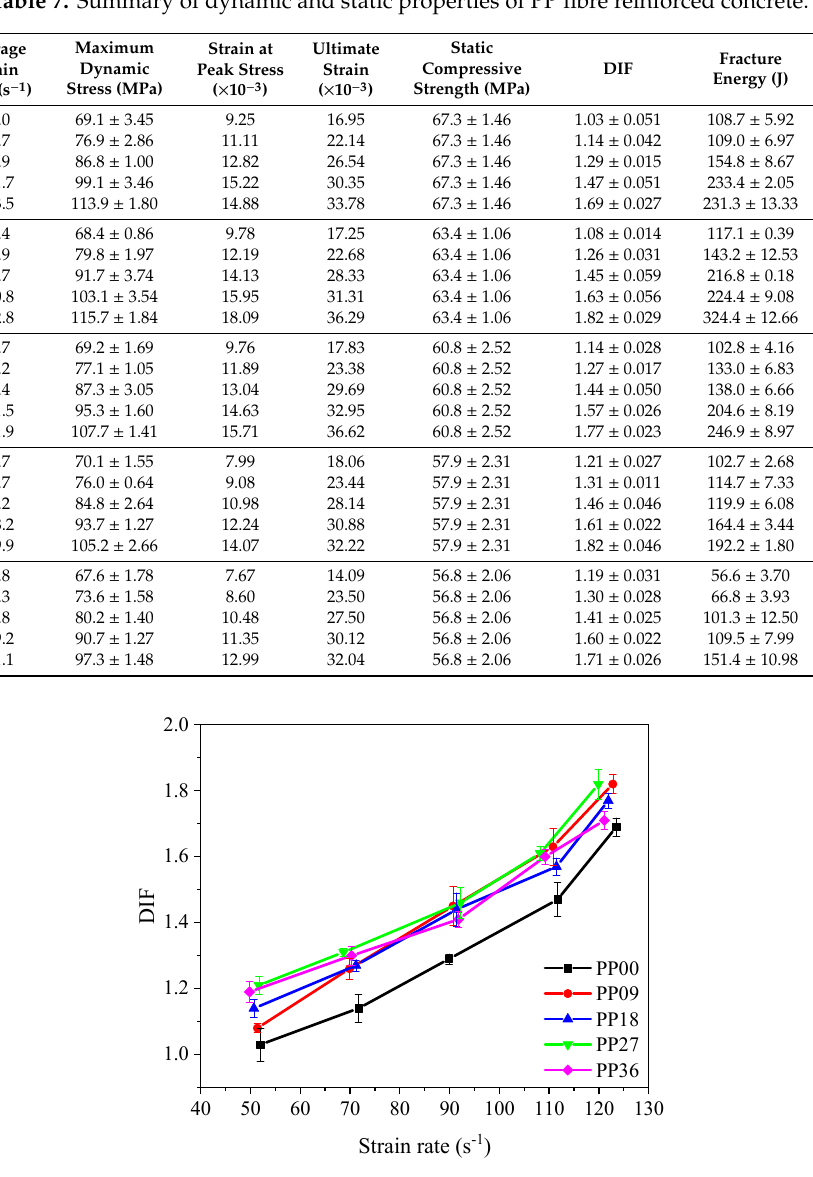
Figure 9. Energy absorption capacity of concrete at different strain rates:( a ) Fracture energy;( b ) Tolal energy. The deformation capacity of concrete materials can be represented by the strain at peak stress and ultimate strain listed in Table 7.The strain at peak stress and ultimate strain were improved with increasing strain rate. The ultimate strain of each mixture was higher than its strain at peak stress ranging from 83.2% to 173.3%.The ultimate strain of PP09 and PP18 in this study was higher than that of PP00. This can be attributed to the bridging action of the fibres in cracks, which prolongs the strain-softening region and subsequently improves the toughness of FRC. 3.3.2. Effect of Polypropylene Fibre Content The effect of PP fibre content on DIF of all concrete mixtures is presented in Figure 10. At the strain rate of around 50 s − 1 , the DIF of PP09, PP18, PP27 and PP36 increased 4.9%, 10.7%, 17.5% and 15.5%, respectively as compared to PP00. When the strain rate was around 70 s − 1 , the DIF of PP09,